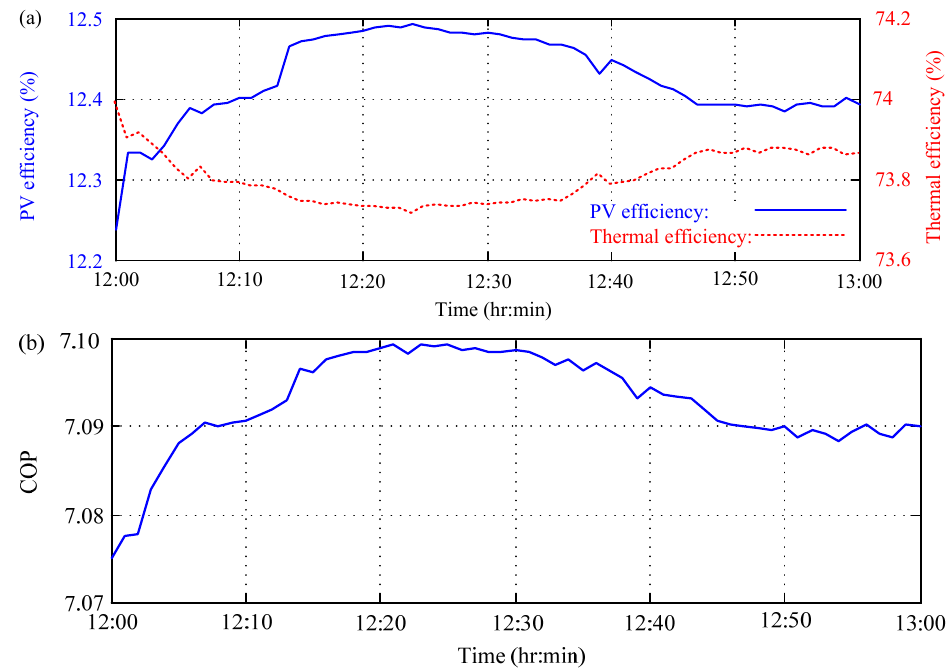
Figure 8. Performance analysis of PVTA-HPWH system on a typical sunny day (18 June 2013): ( a ) PV and thermal efficiency; ( b ) COP.